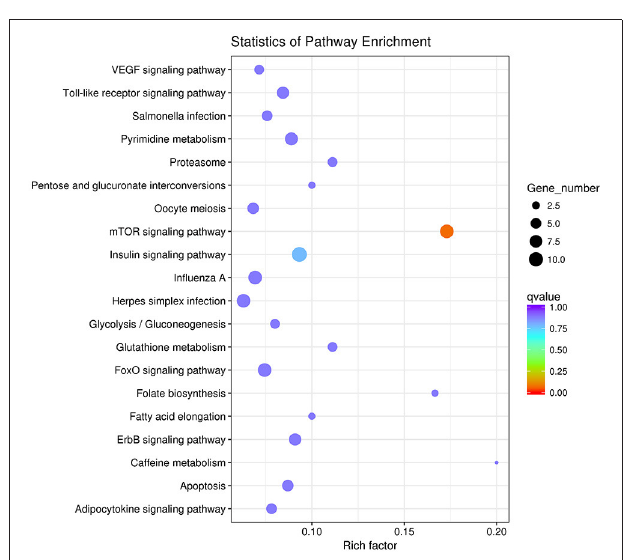
FIGURE 16 | The top 20 enriched KEGG pathways of the differentially expressed target genes of novel-72.